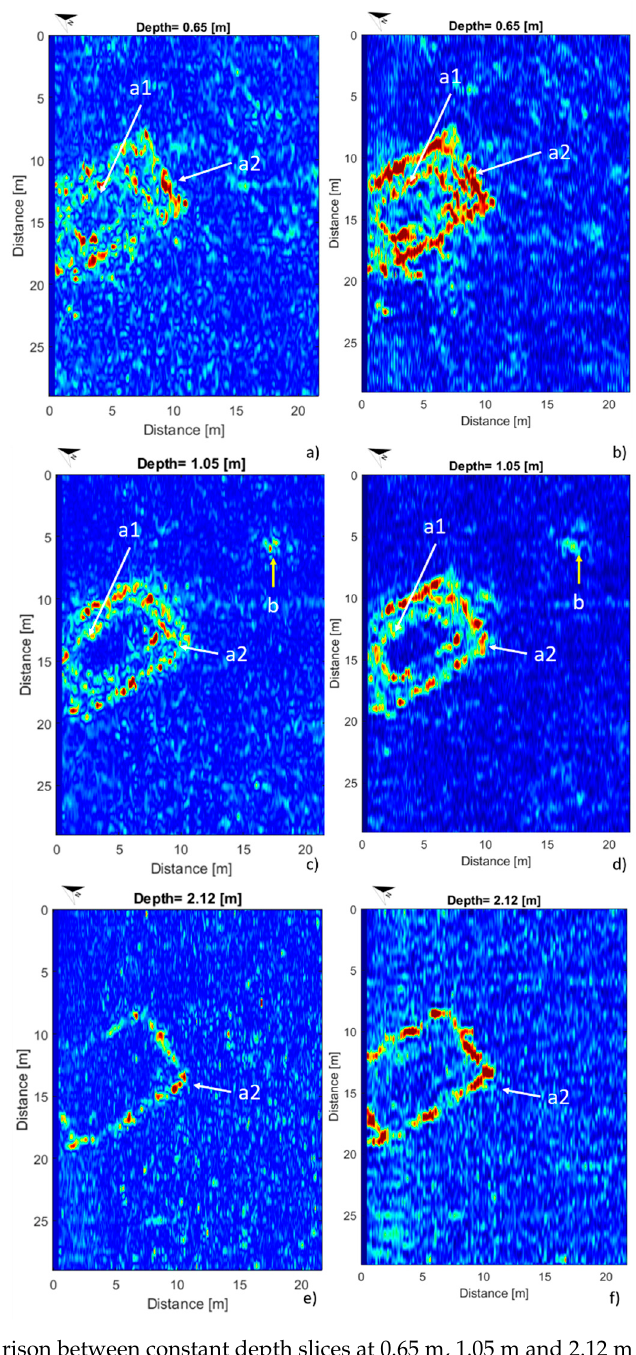
Figure 10. Comparison between constant depth slices at 0.65 m, 1.05 m and 2.12 m extracted from 200 MHz data. Time domain filtered radargram ( a , c , e ). Tomographic reconstruction ( b , d , f